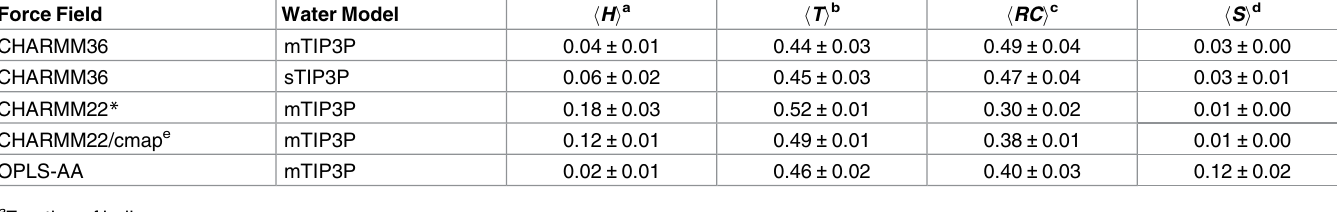
Fig 2 and Table 1 that its conformational ensemble is dominated by random coil ( h RC i = 0.49 ± 0.04) and turn ( h T i = 0.44 ± 0.03), which together account for 93% of all amino acid states. Indeed, the turn structure is stable (i.e., its fraction h T ( i ) i > 0.5) for few S1 residues (His13, His14) and within the long sequence span Phe19-Gly29 covering the part of hydropho- bic region S2, the entire hydrophilic S3, and the beginning of C-terminal S4. Random coil structure dominates the N- and C-terminals and the Gln15-Val18 region. The occurrence of Table 1. Secondary Structure in A β